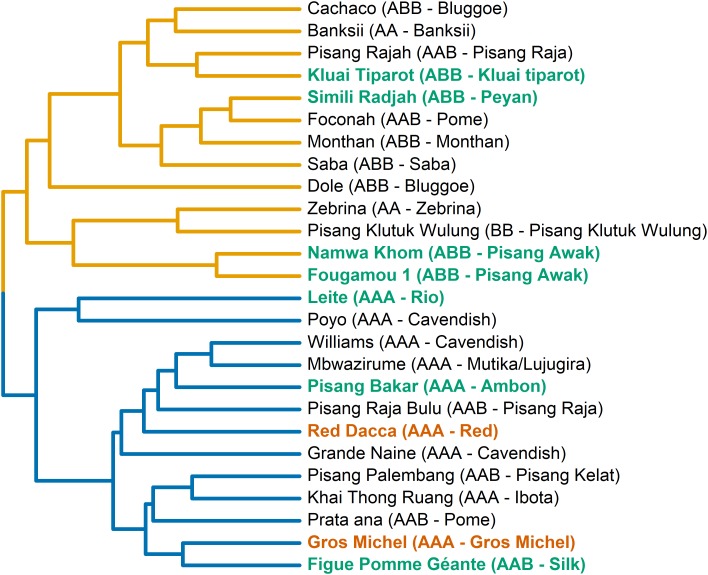
Two transpiration phenotypic groups are separated based on the phenotypic similarity tree. The tree is constructed based on the average phenotypic difference between genotypes. The transpiration phenotypic groups are indicated here by the color of the lines in the tree (yellow: group A, blue: group B). To couple to the growth performance (Figure 1) cultivars from performance group 1 are colored in green, and group 2 in red. Names of cultivars, their genomic constitution and the subgroup they belong to are given.